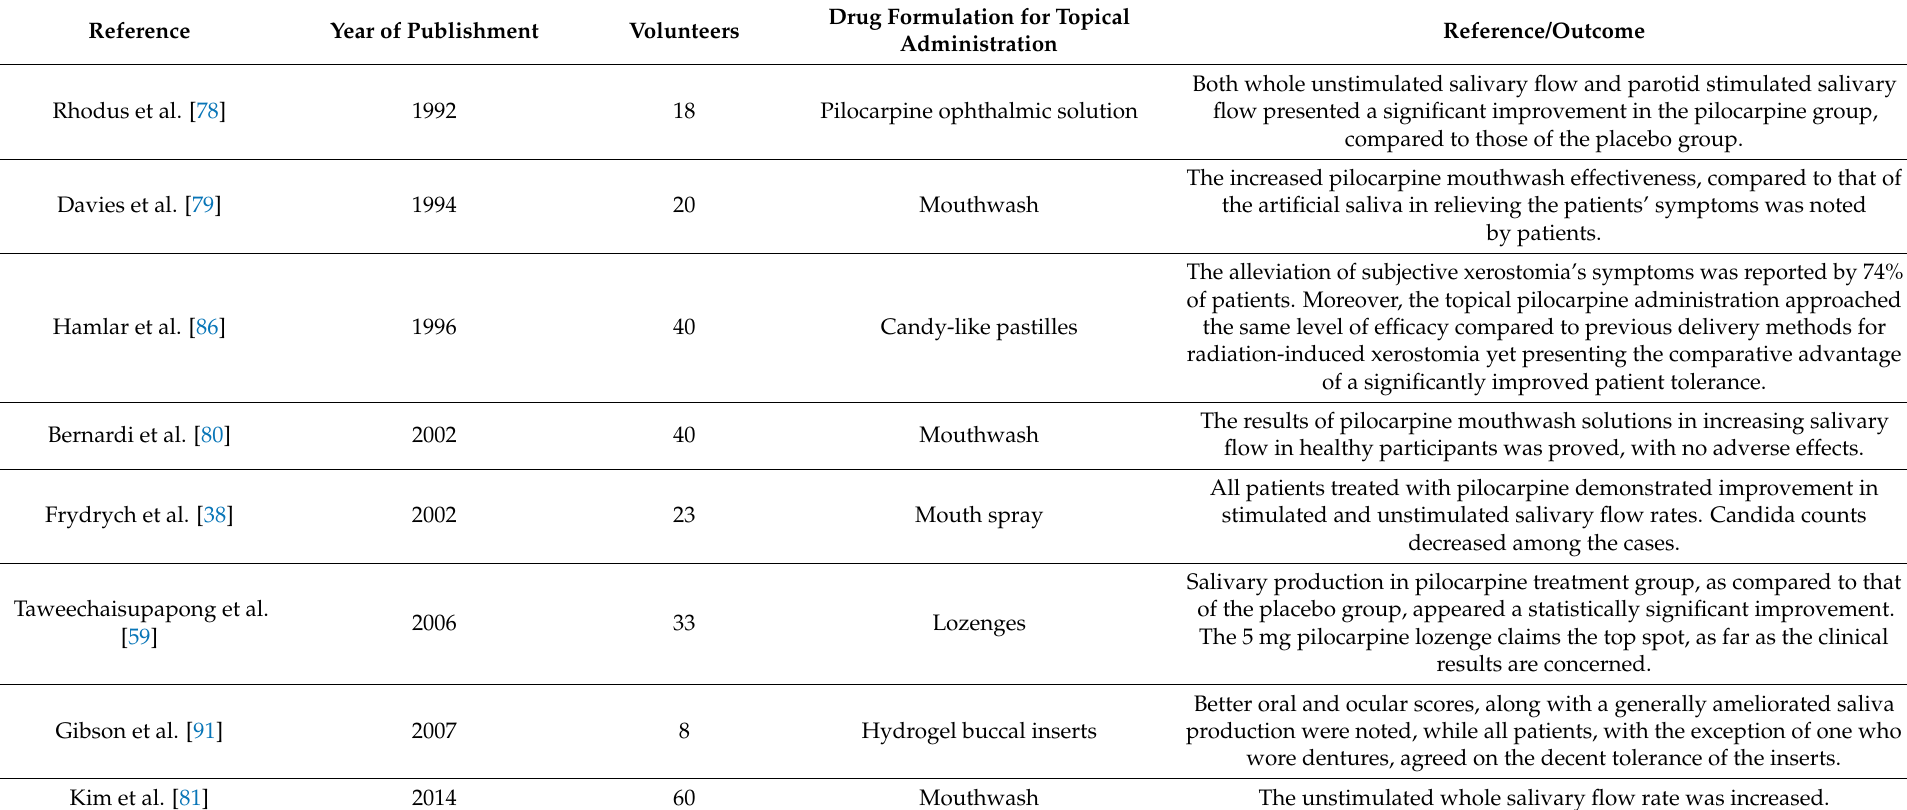
Table 2. Published studies evaluating the clinical efficacy of topical pilocarpine delivery formulations in improving salivary gland flow and relieving symptoms of xerostomia. The studies are presented in chronological